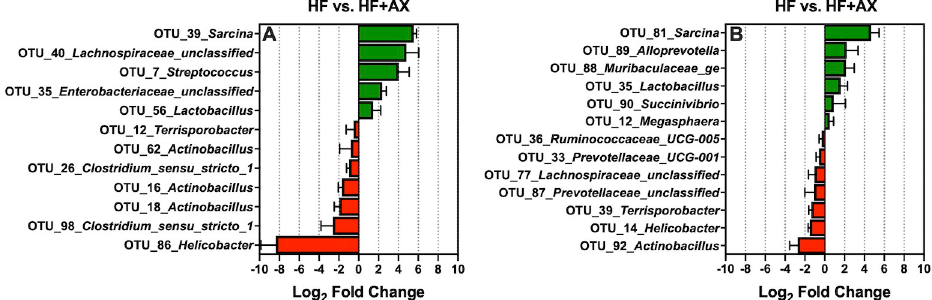
Fig 7. The log 2 -fold change differences between HF vs. HF+AX for the significant OTUs from the 100 most abundant OTUs among treatments present in the ileal digesta (A) and mucosa (B).